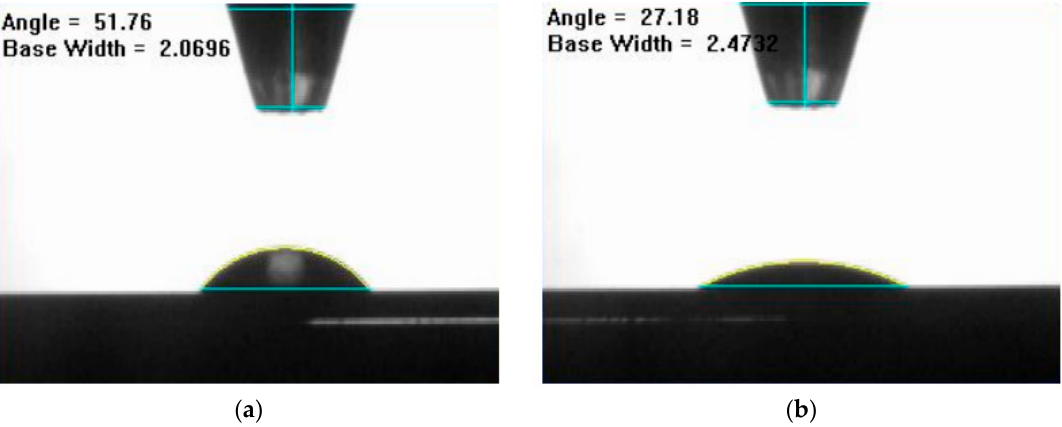
Figure 8. Demonstration of surface tension and how it can be affected with an ionic surfactant: ( a ) High surface tension ink with a large contact angle; ( b ) Low surface tension ink with a small contact angle. Reproduced from [44].